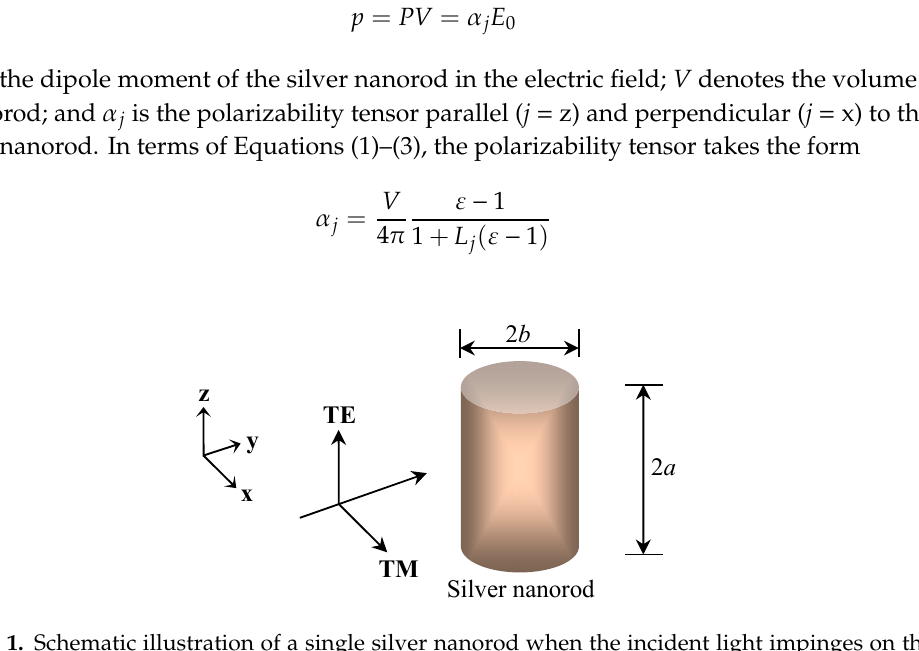
Figure 1. Schematic illustration of a single silver nanorod when the incident light impinges on the surface of the nanorod at normal incidence along the y-direction, where the z-direction is parallel to the long axis of the nanorod with a length of 2 a and diameter of 2 b . TE and TM correspond to the transverse electric and transverse magnetic polarized waves, respectively.